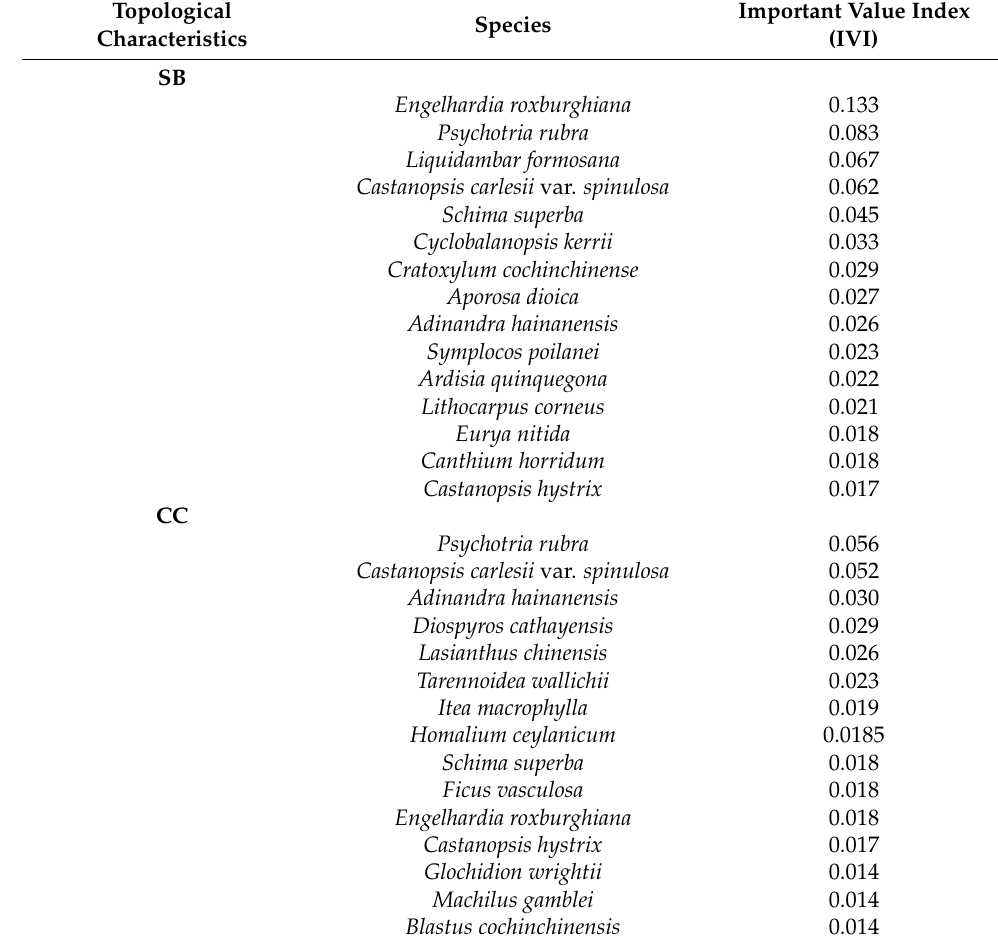
Table A3. Importance value index (IVI) of the top 15 species in the four forest stands.